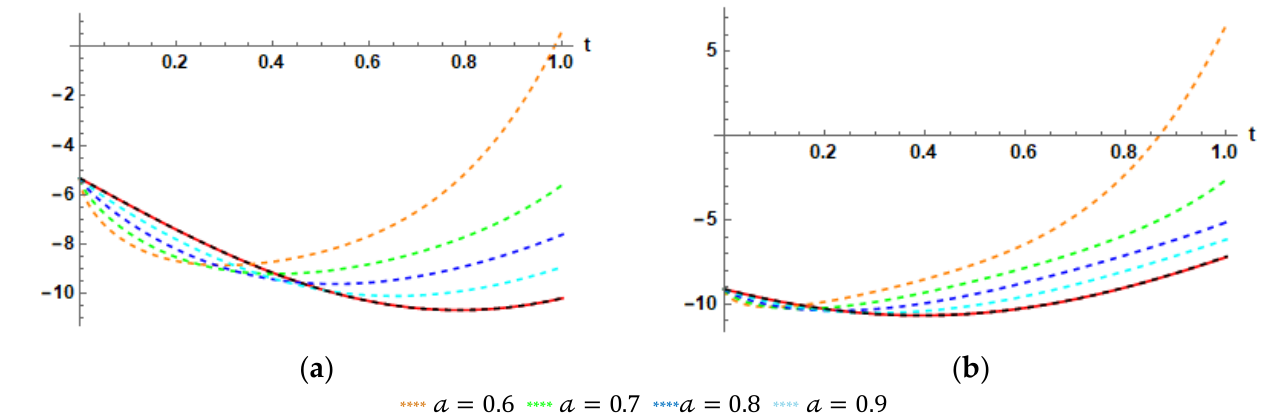
Figure 3. Profile the 7-th approximate solutions 𝒲 (cid:2875) (𝑥,𝑡), at various values of 𝒶 , for the nonlinear